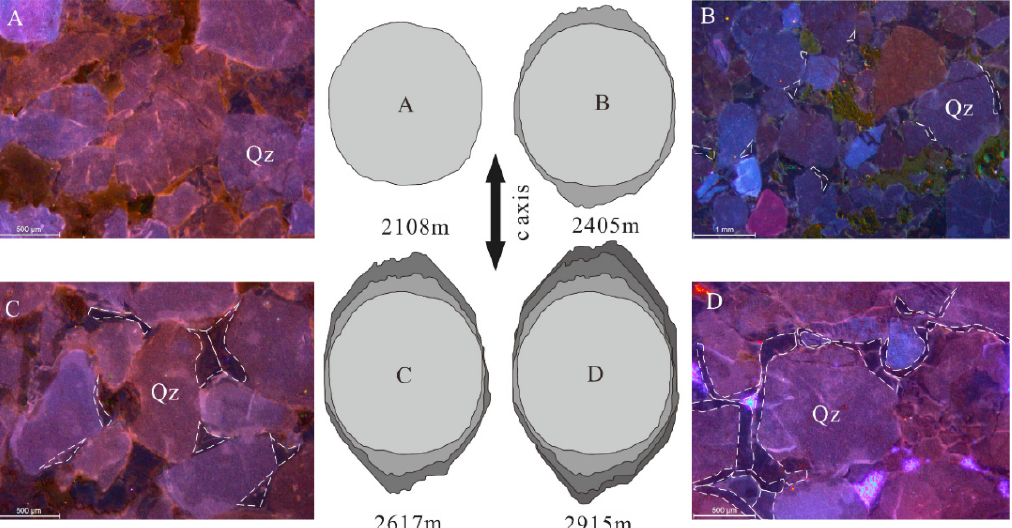
Figure 4. The first stage of quartz overgrowth from the rounding grains to the hexagonal dipyramid crystal; ( A ) non-cement grain; ( B ) film-like siliceous cement around grains; ( C ) porphyritic distribution of siliceous cements; ( D ) grains were restored as hexagonal bicone crystal by siliceous cements.